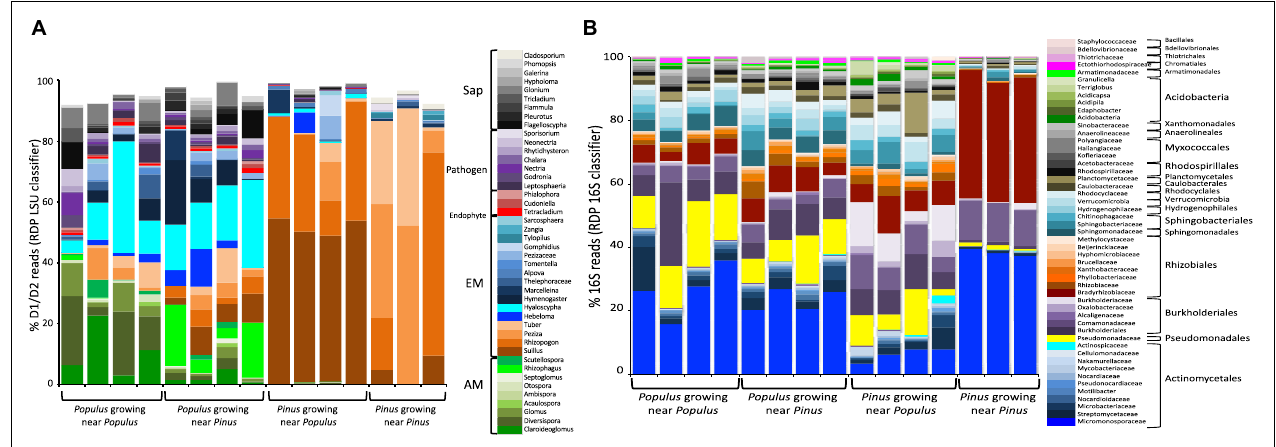
FIGURE 3 | Relative transcriptomic abundances of fungal (A) and bacterial (B) taxa present in root samples determined by the relative proportion of rRNA LSU D1/D2 reads (A) , or 16S rRNA reads (B) recovered from roots of individual plants. The color key indicates fungal taxa grouped at genus level (RDP classifier with > 60% bootstrap support). Reads belonging to unknown taxa and taxa with < 0.5% reads were not included. Computational workflows for data analyses are shown in Supporting Information Text A2 and Supplementary Figure 2